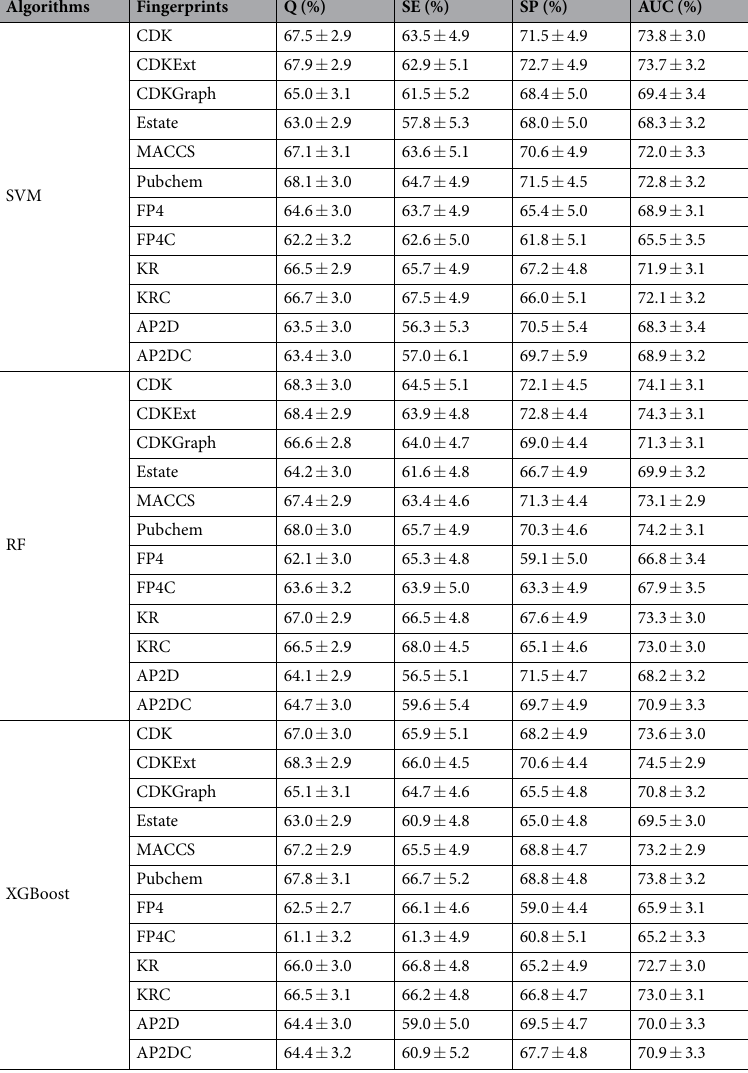
Table 1. Performance of the basic classifiers in five-fold cross-validation. The performance values are represented as means and standard deviation.